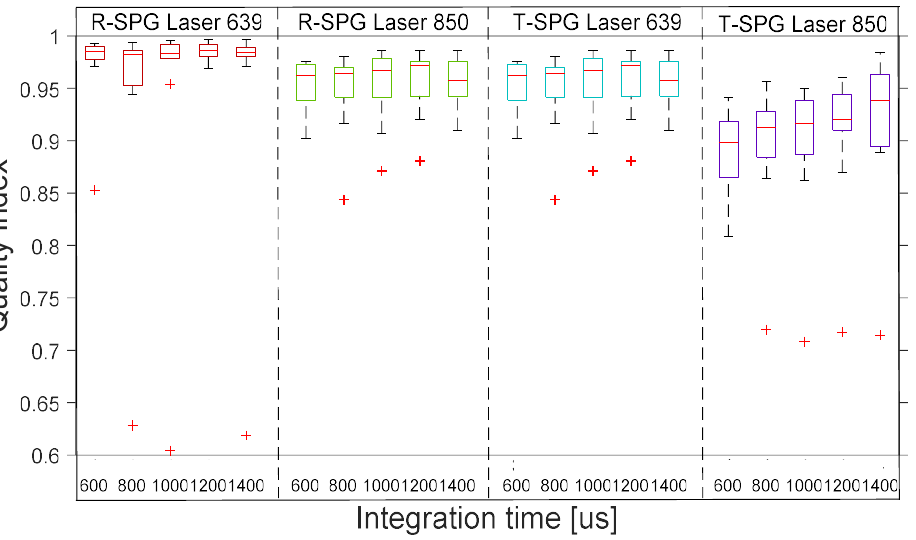
Figure 13. Boxplots of quality index of rSPG signals with 4 different lights at 5 integration times with coherent light in transmission and reflection. The inner box divisions indicate: Q1 (the first quartile) to Q3 (the third quartile). The median is marked by a line across the box. The “whiskers” indicate results from Q1 and Q3 to the most extreme data points. The + symbols represent outliers.